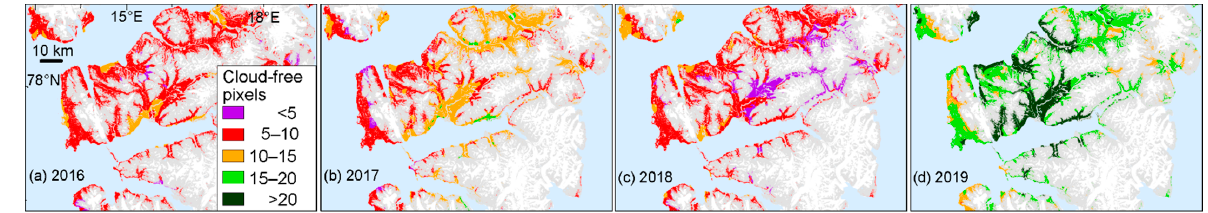
Figure 3. Central Svalbard. Number of cloud-free pixels for the season: ( a ) 2016; ( b ) 2017; ( c ) 2018; ( d ) 2019.